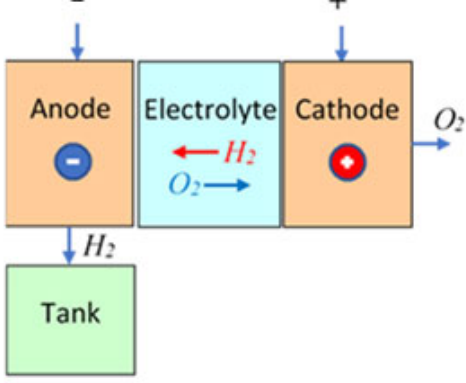
Figure 12. Scheme of an electrolyser.